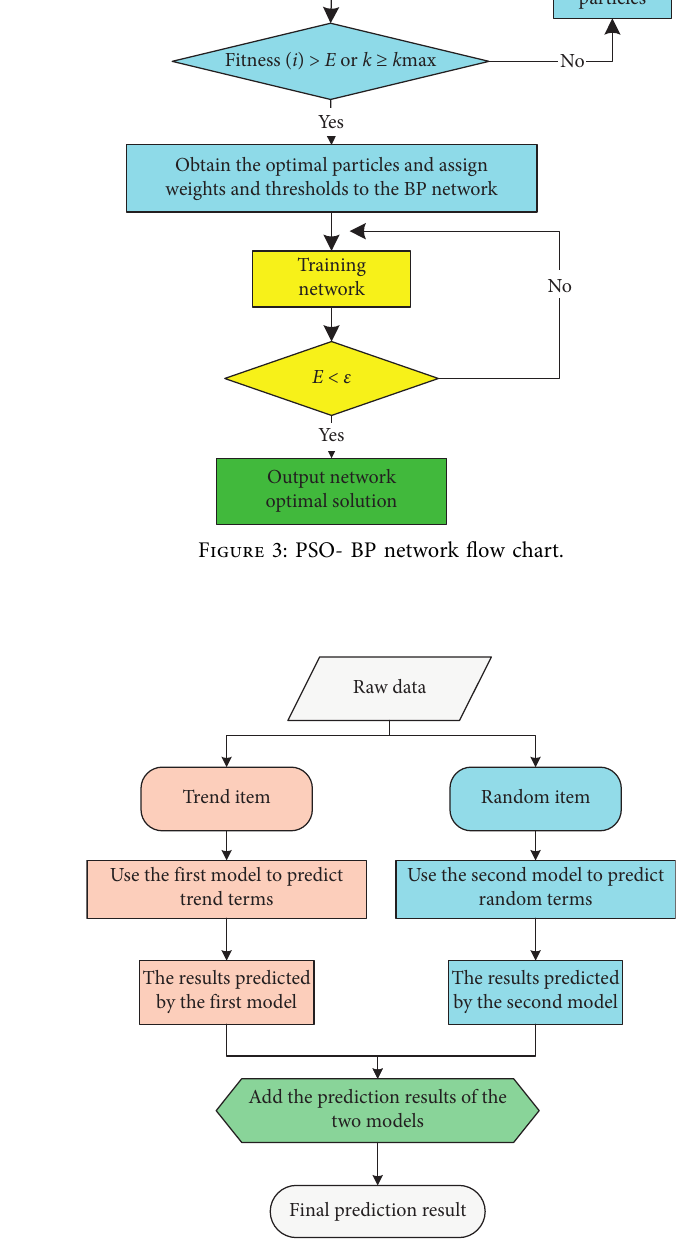
Figure 4: Combined forecasting flow